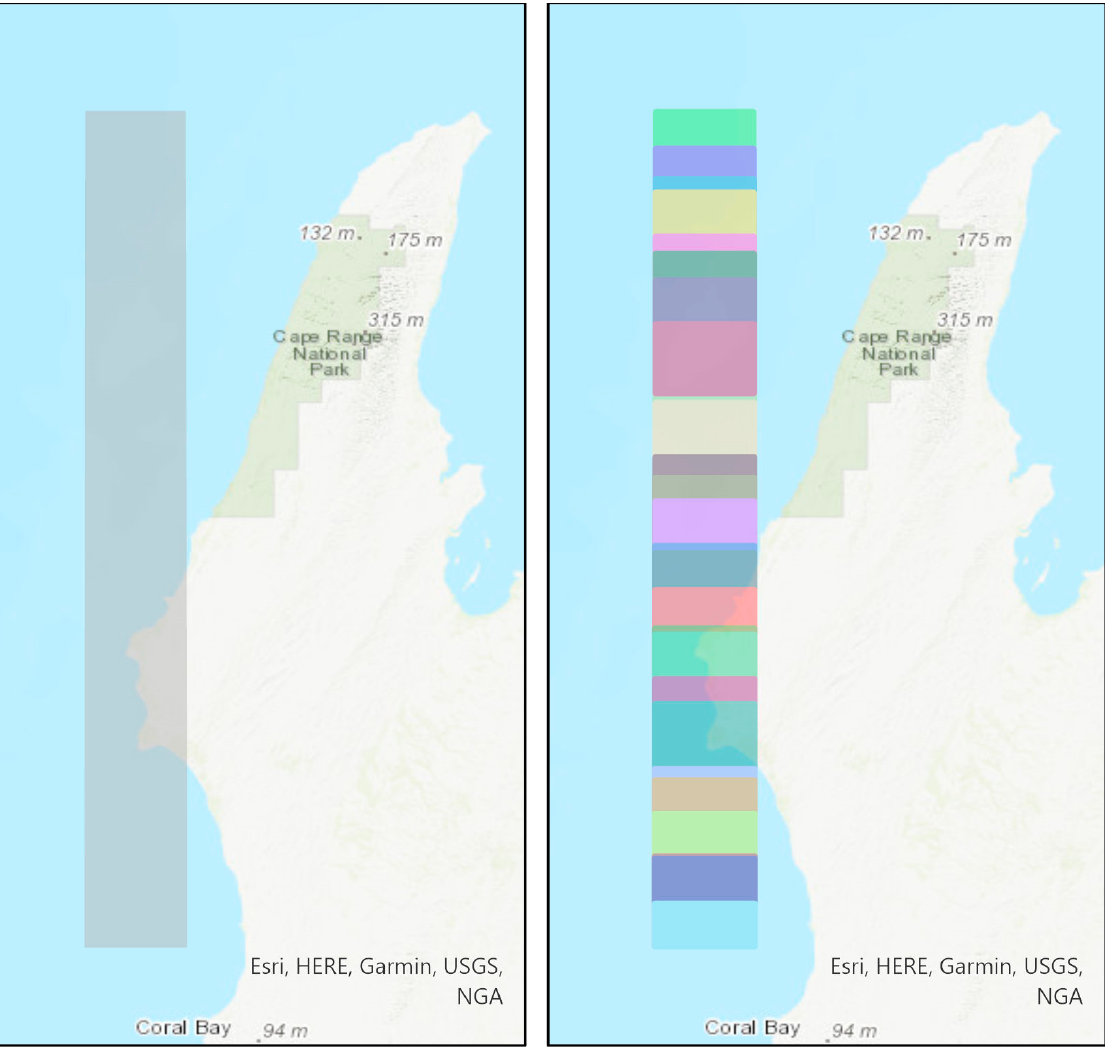
Figure 7. Results from querying and downloading a specific Catalog ID (104001002090DF00) through the G-EGD web interface as a full image strip ( left ) and through Earth Explorer as tiled images ( right ).